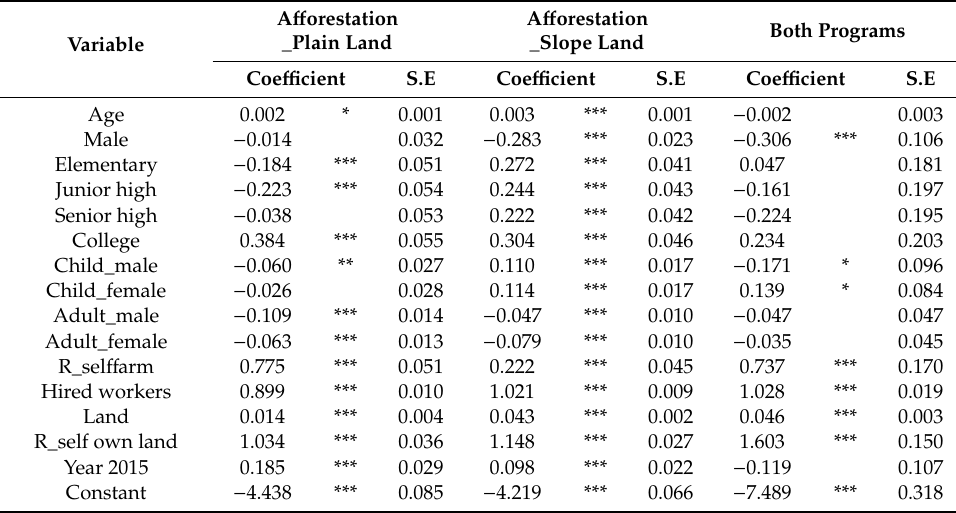
Table 2. Estimated coe ffi cients of the multinomial logit